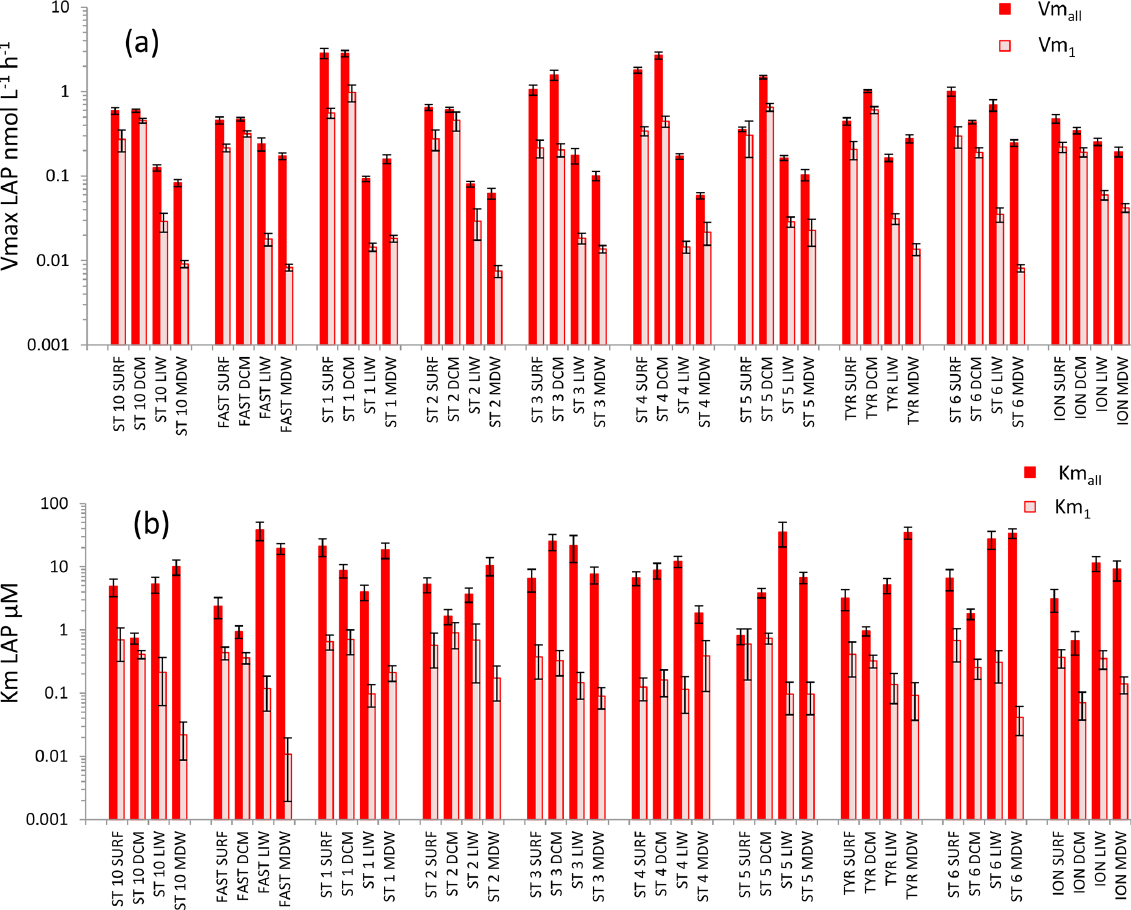
Figure 5. Distribution of kinetic parameters Vm (a) and Km (b) for leucine aminopeptidase (LAP) calculated from model 1 (Vm 1 , Km 1 ) and the global model (Vm all , Km all ). Error bars represent the standard errors derived from the nonlinear regressions. Table 3. Turnover times of ectoenzymes (Km / Vm ratio). Mean ± SD and range values given. For leucine aminopeptidase (LAP), β - glucosidase ( β GLU) and alkaline phosphatase (AP). The turnover times are calculated from the global model (Km all / Vm all ) or the model 1 (Km 1 / Vm 1 ); nk: no kinetics available as there are not enough significant rates to plot Michaelis–Menten